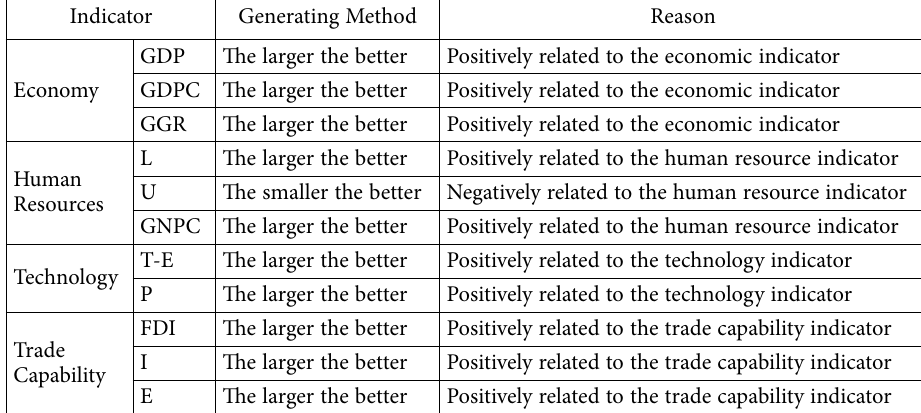
Table 2. Grey relational generating methods Indicator Generating Method Reason GDP The larger the better Positively related to the economic indicator Economy GDPC The larger the better Positively related to the economic indicator GGR The larger the better Positively related to the economic indicator The larger the better Positively related to the human resource indicator Human Negatively related to the human resource indicator Resources Positively related to the human resource indicator Positively related to the technology indicator Positively related to the technology indicator Positively related to the trade capability Trade Capability